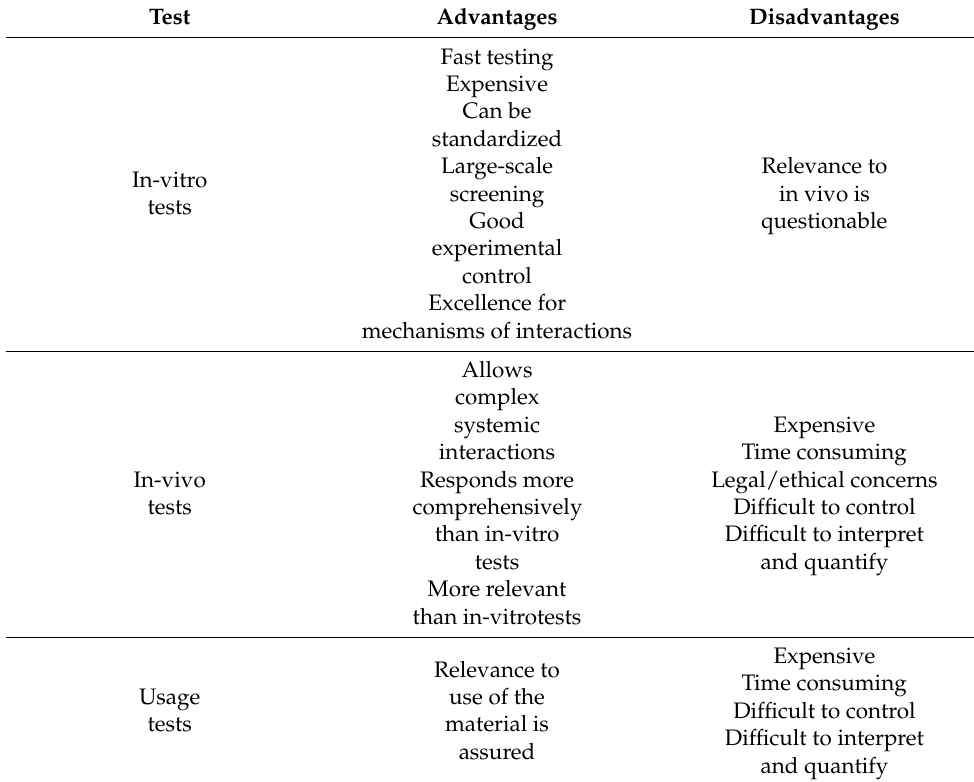
Table 7. Advantages and disadvantages of biocompatibility tests